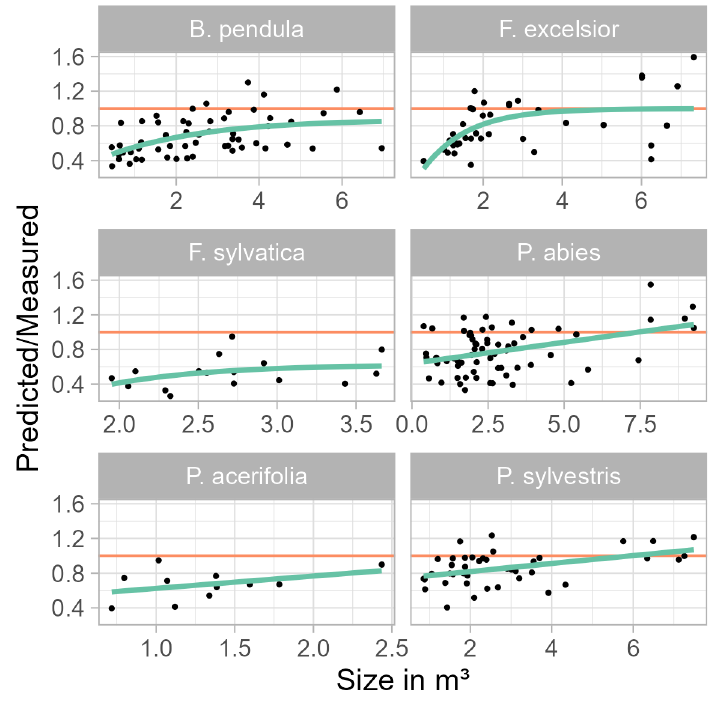
Figure 6. The ratio of estimated (Equation (3)) and measured anchorage strength approaches 1 (red line) for large trees. Three outliers > 2 removed. Fitted curve: y = y 0 ∗ e − a ∗ Size + b . ANOVA: Table